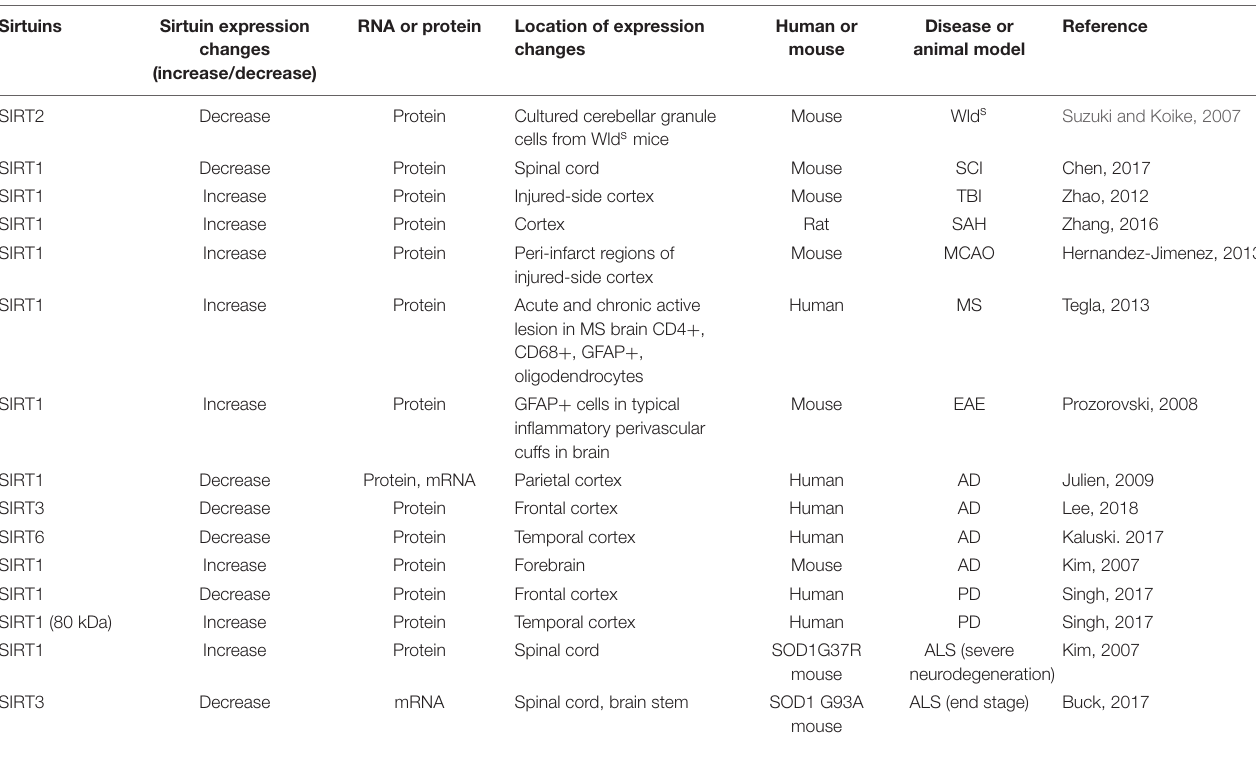
TABLE 2 | The expression changes of sirtuins in neurological diseases and animal models. Sirtuins Sirtuin expression RNA or protein changes (increase/decrease)